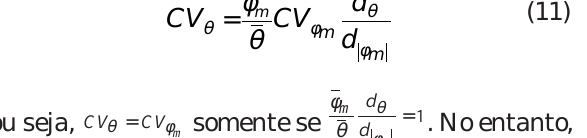
para qqqqq : tratamento tr0I0, profundidade de 0,20 m m